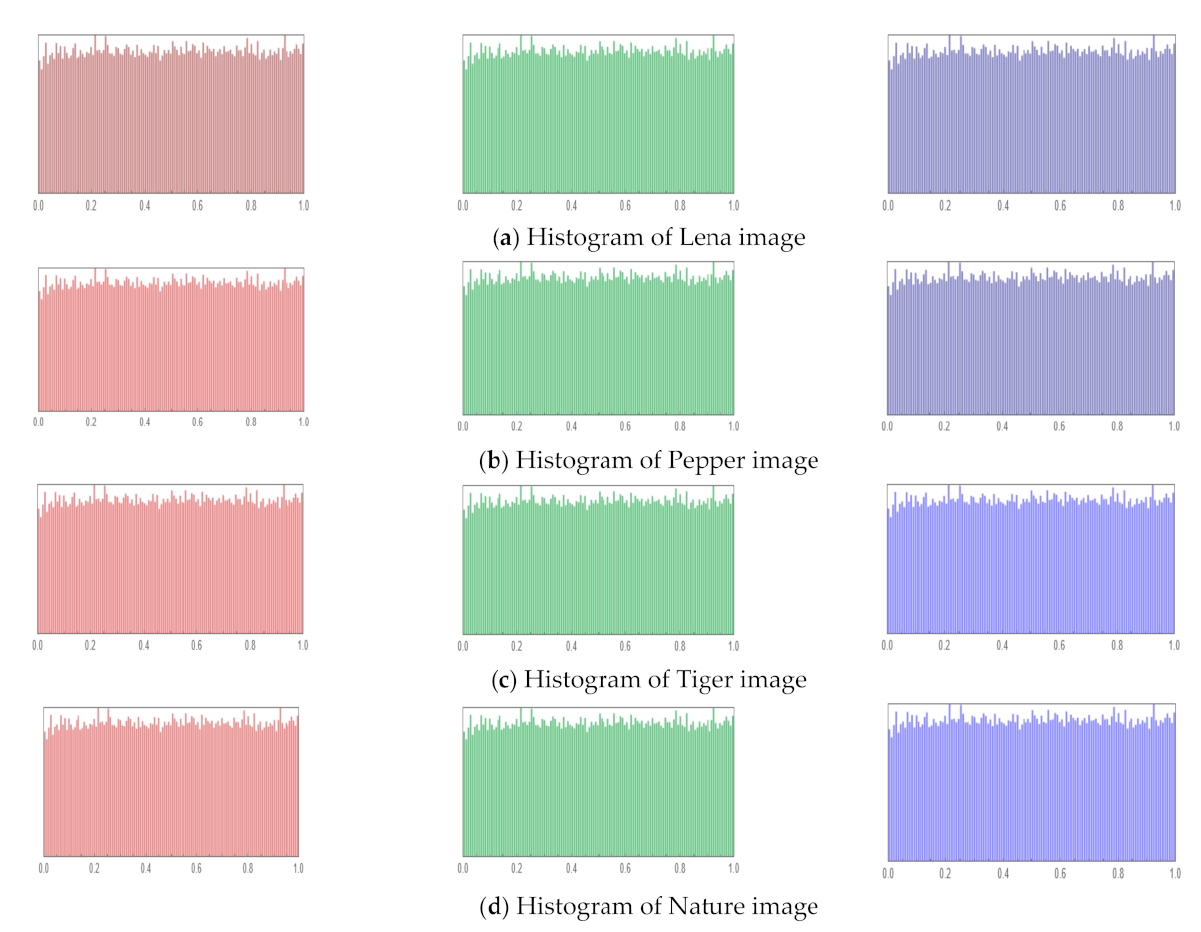
Figure 9. The encrypted images’ histograms.